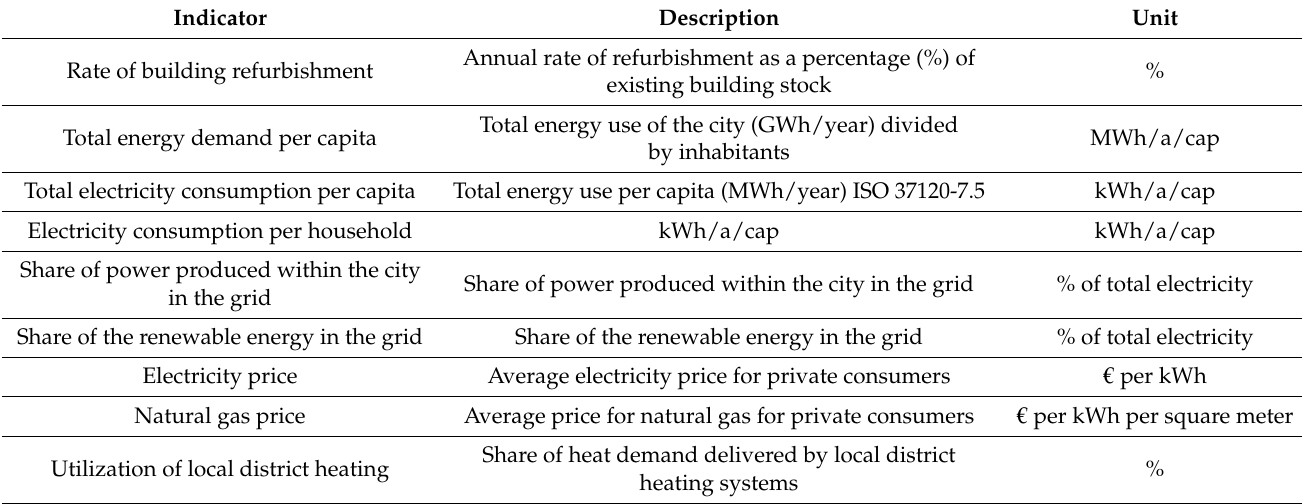
Table 3. Overview of indicators for data collection for SPARCS fellow cities.